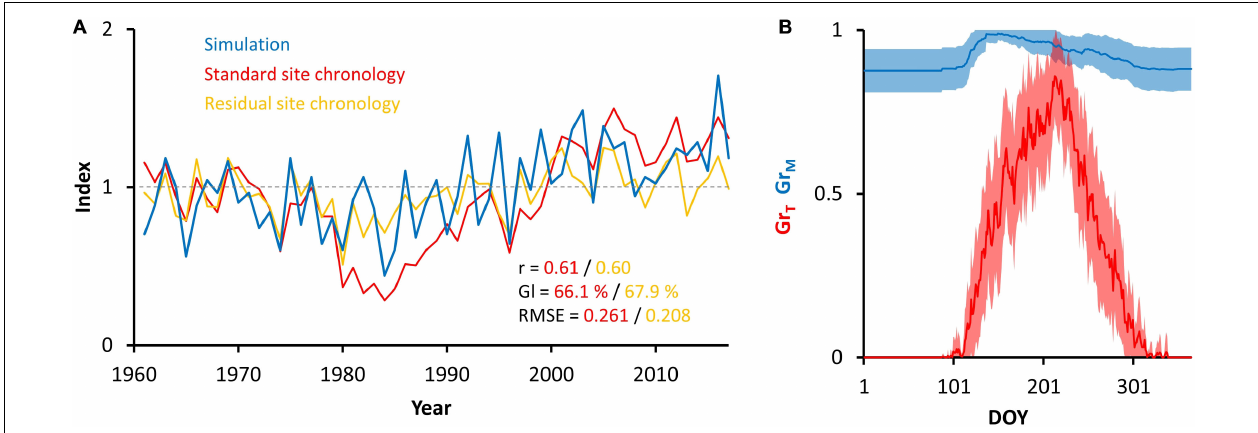
FIGURE 3 | Annually resolved outputs of VS-model. Comparison of simulated (blue) and observed standard (red) and residual (yellow) chronologies together with their coherency statistics (A) , and intra-annual variability in mean ( ± SD) partial growth rates related to temperature (red) and soil moisture (blue) (B) . r = Pearson correlation coefficient; Gl = Synchronicity index; RMSE = root mean-squared error.